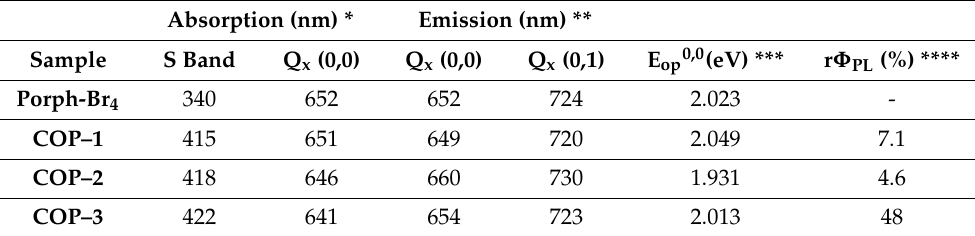
Table 2. Photochemical properties in acetonitrile of the Porph-Br 4 monomer and the three COPs under